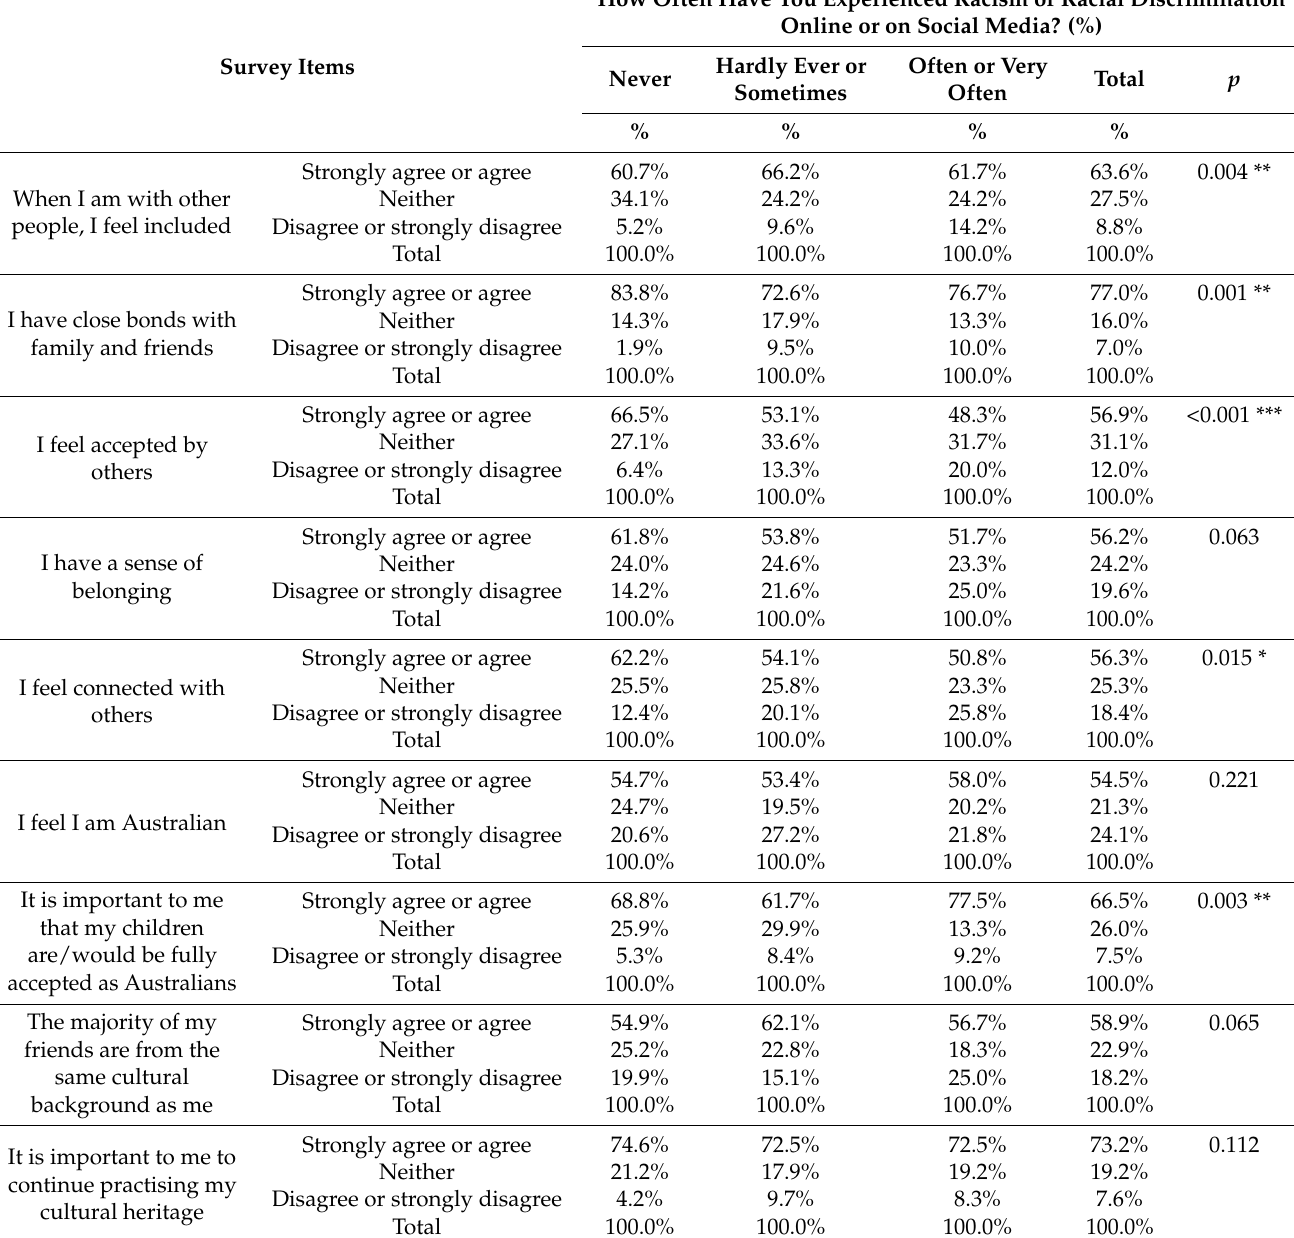
Table 6. Sense of belonging by experience of online racism during the COVID-19 pandemic, n = 798.